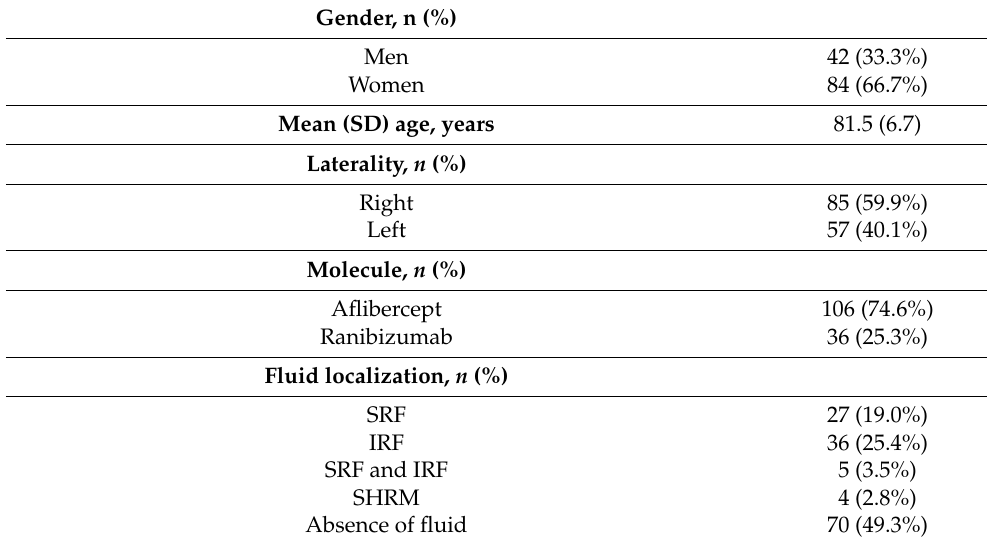
Table 1. Demographics and disease characteristics at the study